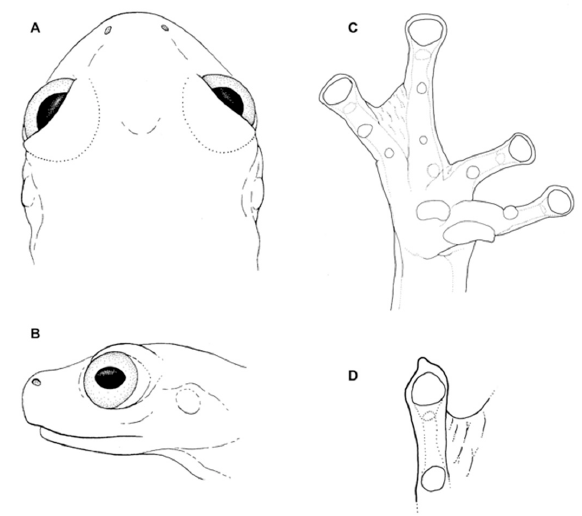
Figure 223. Vitreorana ritae . ( A ) Head in dorsal view, MCZ 96522. ( B ) Head in lateral view, MCZ 96522. ( C ) Hand in ventral view, with exposed prepollex, ICN 50847. ( D ) Toe I in ventral view, with papilla at tip. Not drawn to scale. (A, B) Modified from Flores [314]; (C, D) by Juan M. Guayasamin.